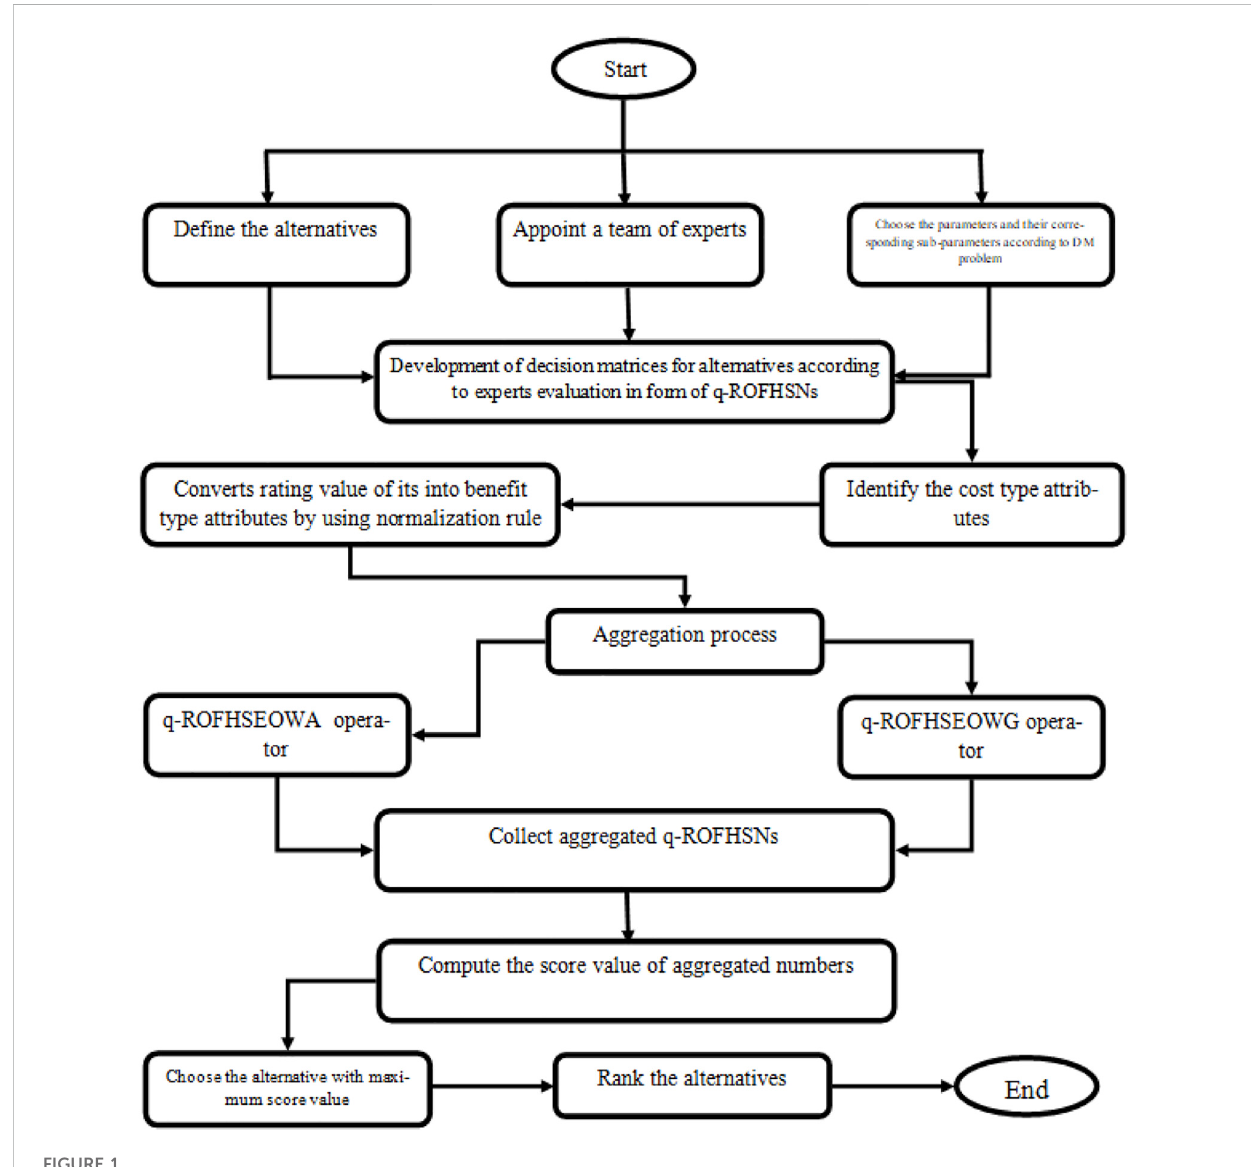
FIGURE 1 Flowchart of the proposed MCGDM